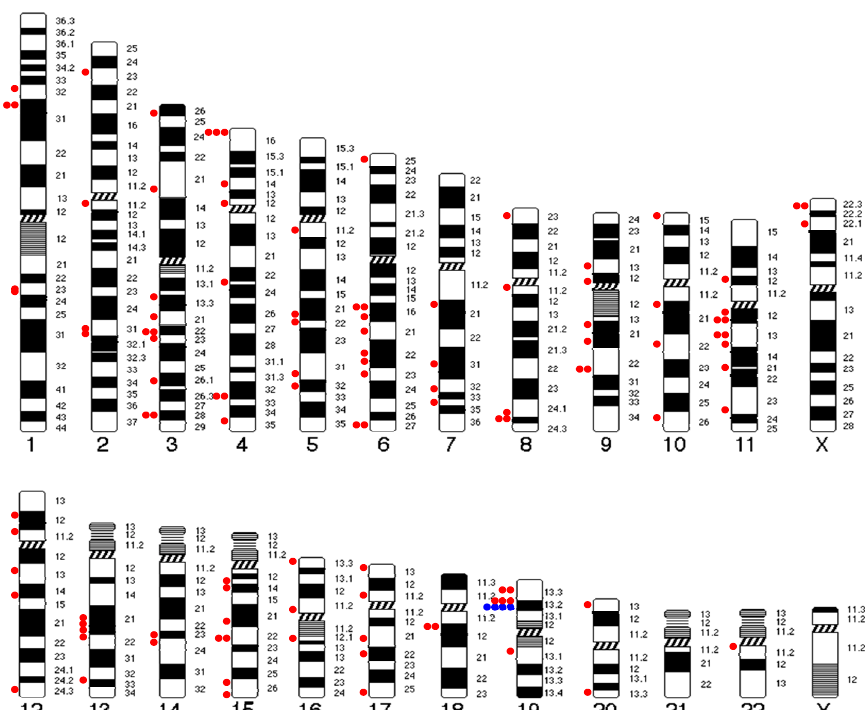
Figure 2. Distribution of HPV insertion sites in the genome of patients with HPV-positive anal squamous cell carcinoma (ASCC). Each dot represents an HPV integration site. Four intragenic integration events in the NFIX gene located at 19p13.2 were identified (blue dots) as well as three other integration events adjacent to the NFIX gene but nonintragenic (red dots), of unknown significance.